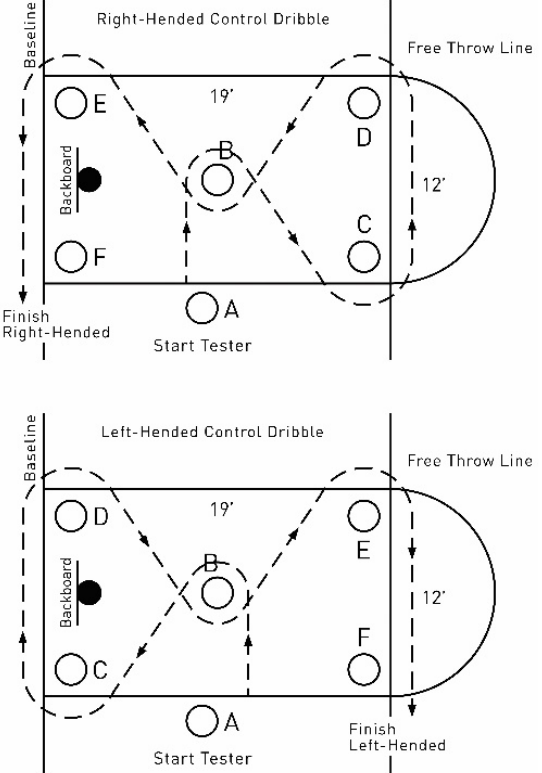
Figure 1. Schematic illustration of the Control of dribbling test. A, B, C, D, E, F—cones; dotted arrow—direction of dribbling.